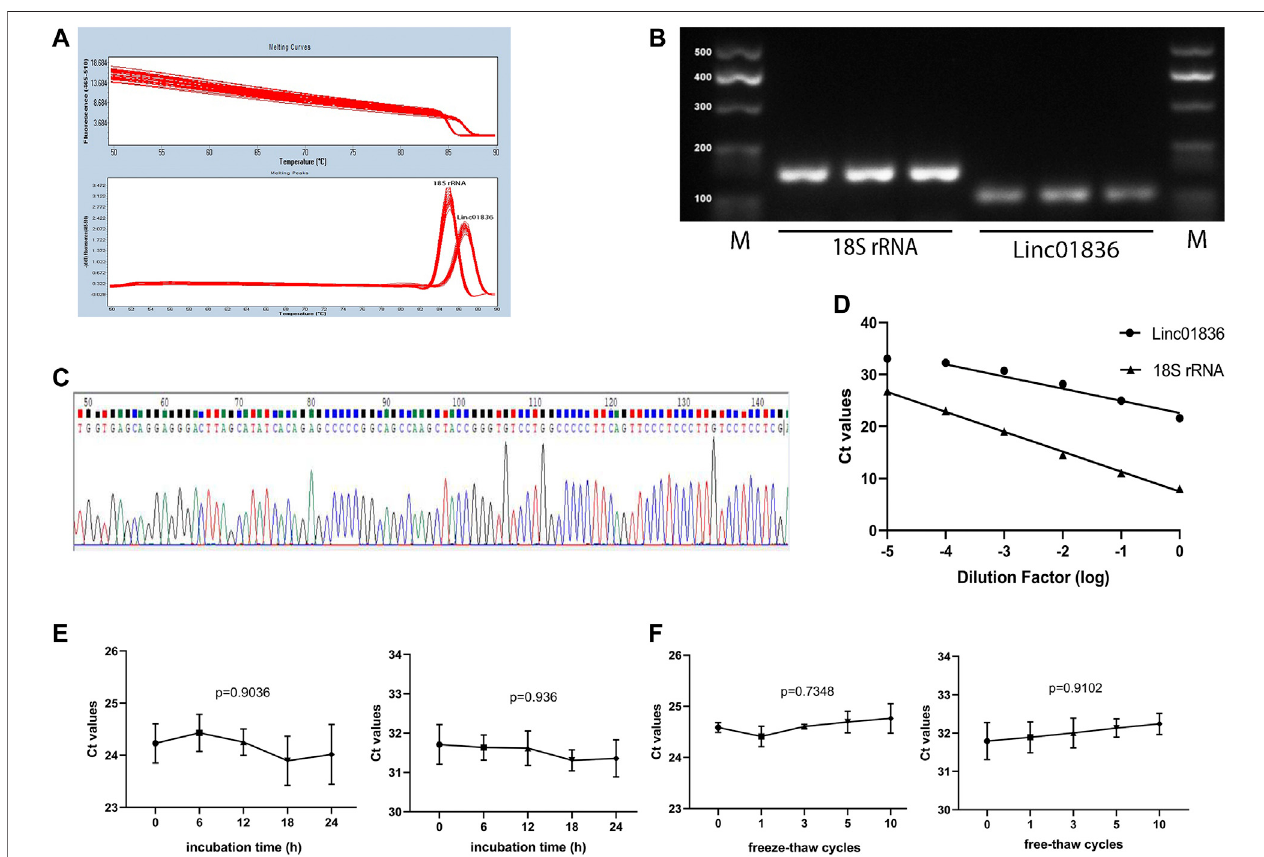
FIGURE 2 | Methodological evaluation of Linc01836. (A) The melting peak of Linc01836 showed a single peak. (B) The qRT-PCR products detected by agarose gelelectrophoresisexhibitedasingleband. (C) Sangersequencingalignmentoftheampli fi cationproductwascon fi rmedtobeLinc01836. (D) ThelinearityofLinc01836 and 18S rRNA were acceptable. (E, F) The detection of 18S rRNA and Linc01836 at room temperature within 24 h and repeated freeze-thaw cycles showed good stability. * p < 0.05, ** p < 0.01, *** p < 0.001, **** p < 0.0001, NS p > 0.05.